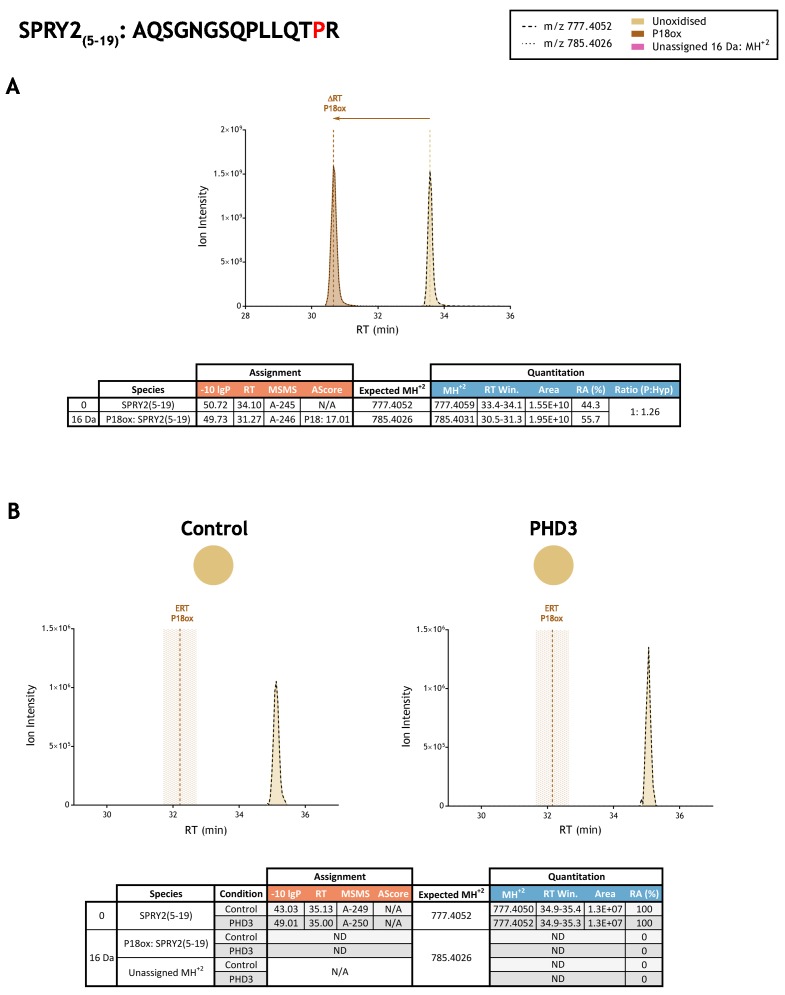
Quantitation of peptide oxidation on SPRY2(5–19) following reaction of full-length sprouty homolog 2 with recombinant PHD3.XIC data presented in (A) shows ion intensity and retention time (RT) characteristics of equimolar synthetic peptide standards for unoxidised and P18ox forms of the SPRY2(5–19) peptide. MSMS assigned species are coloured (see inset); vertical dashed lines define peak maxima used to derive ΔRT values for P18ox. Panel (B) shows comparable XIC data for protease-digested IVTT substrate under control (left) or PHD3-reacted (right) conditions. Peaks corresponding to unoxidised SPRY2(5–19) were assigned by MSMS (see inset for colour code); P18ox was not detected. The estimated RT (ERT) for P18ox, derived from (A), is indicated by dashed vertical line, shading corresponds to a 1 min RT window. Unassigned ions of compatible mass over charge for hydroxylation were not observed across the elution window. Quantitative data for observed species are presented as pie charts with XIC data. Assignment and quantitation data are tabulated below each panel, table headers are as follows: (−10lgP) significance score of leading assignment at given (RT) with ambiguity score (AScore) for PTM localisation and reference to primary MSMS data in Supplementary file 1. Quantitative data reports ion counts (Area) of observed masses (MH+2) integrated over time (RT Win.), expressed as relative abundance (RA). Data on detection efficiency for synthetic peptides (Panel A, P: Hyp) is an aggregated ratio of prolyl (P) to hydroxyprolyl (Hyp) containing species.